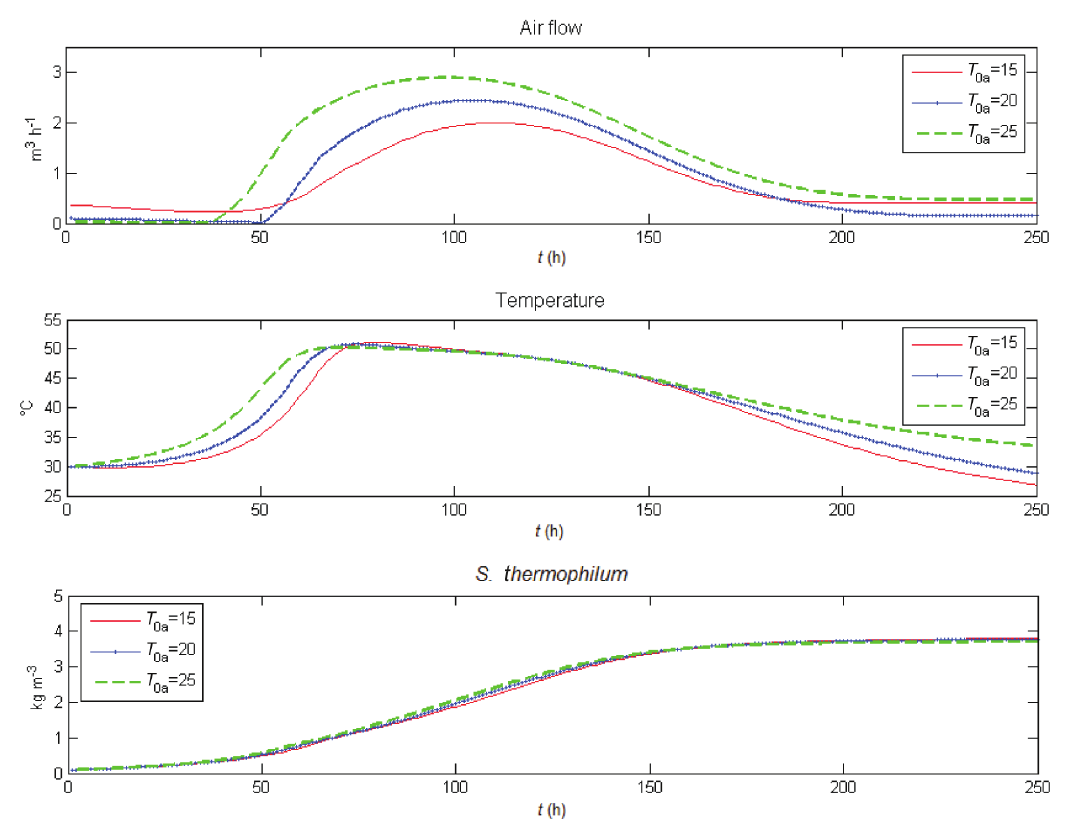
Fig. 8 – SSF model trajectories comparison for temperature disturbance on u